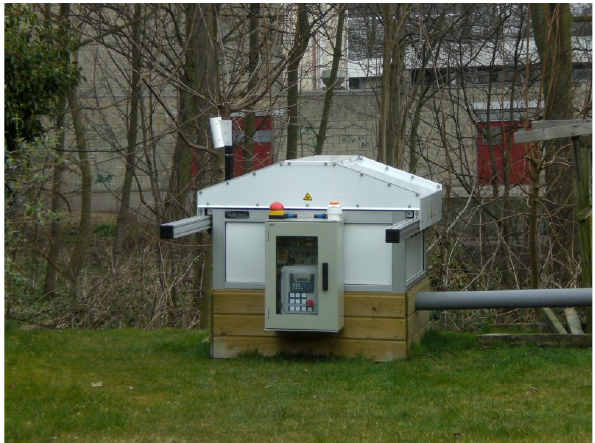
Fig. 4. Roll-off roof in real-sky test